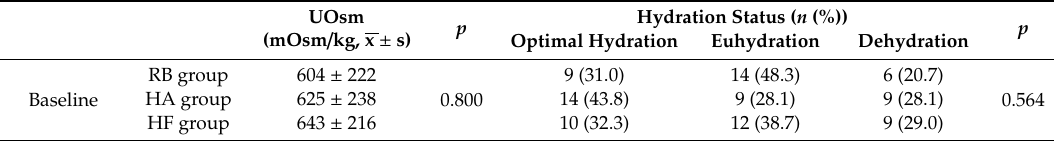
Table 2. Changes in urine osmolality and hydration status of the three